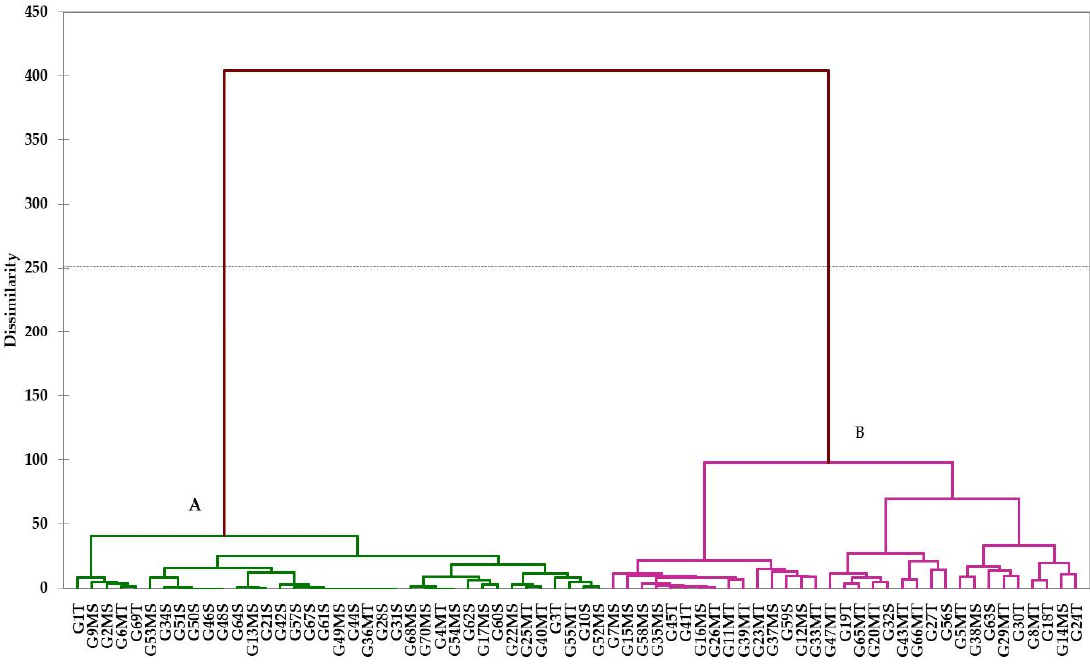
Figure 6. Dendogram from cluster analysis (UPGMA) based on genetic similarity as revealed by SRAP markers analysis. UPGMA indicates unweighted pair group method of arithmetic means.